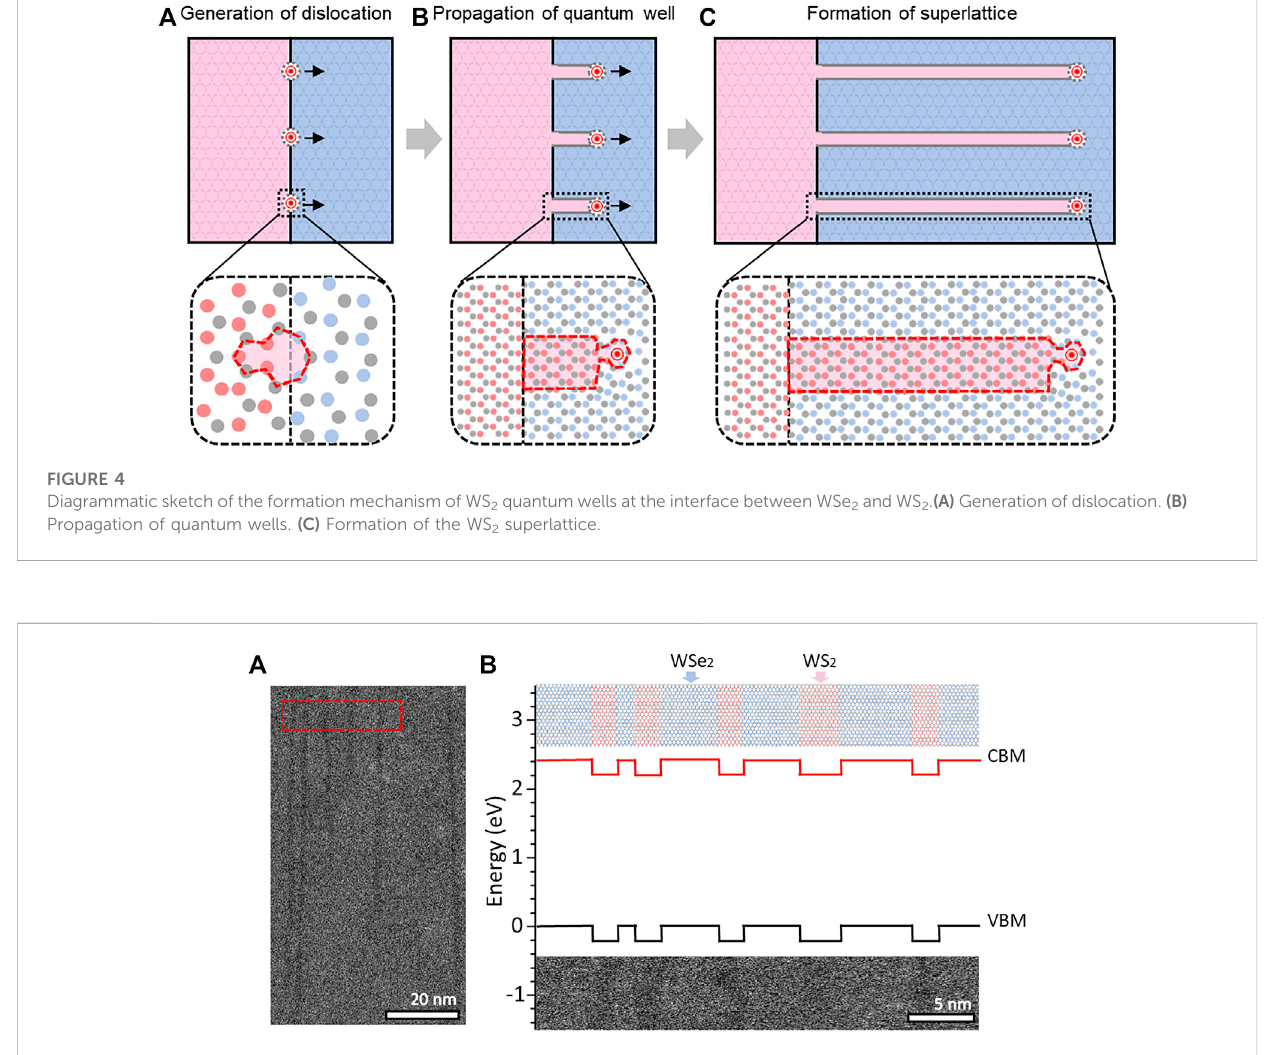
of the red dotted frame in Figure 5A. There are different energy band distributions in the region of tungsten sul fi de and tungsten selenide. From Figure5AandFigure5B,itcanbeconcludedthatthelengthdistributionof